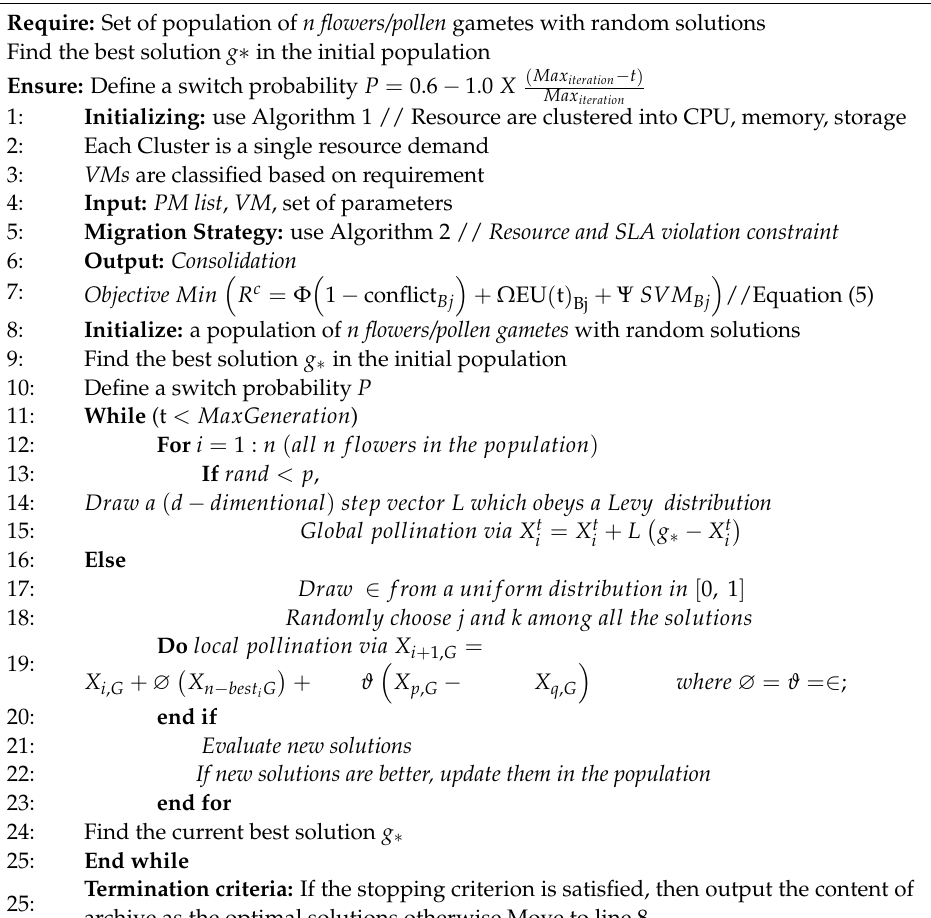
Algorithm 3 Multi-Objective Hybrid Flower Pollination